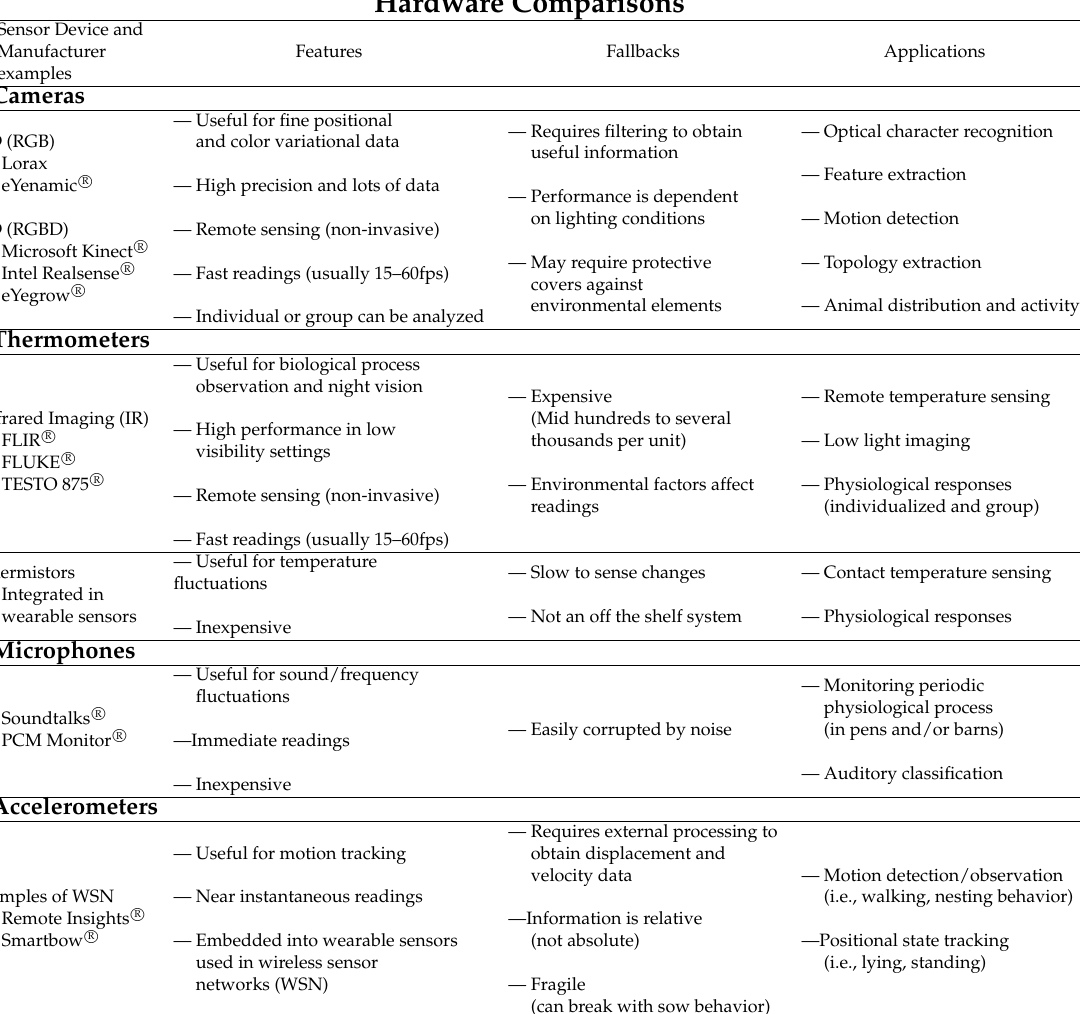
Table 1. A comparison between various sensors and their